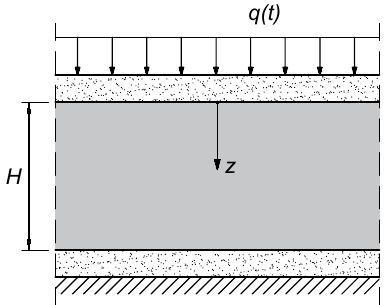
Figure 1. One-dimensional consolidation